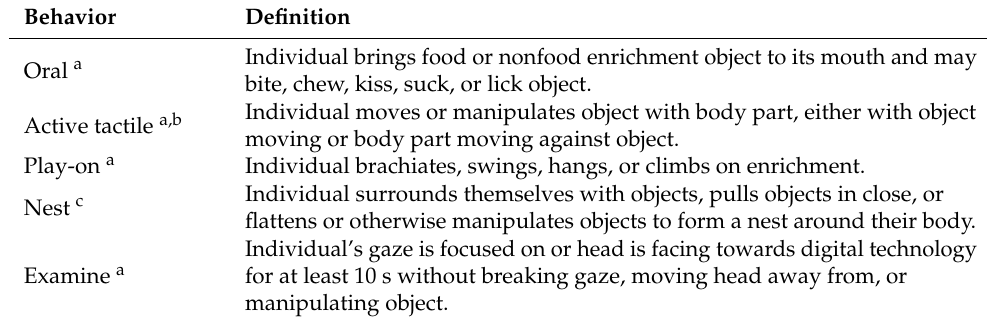
Table 3. Enrichment manipulation behavior ethogram.